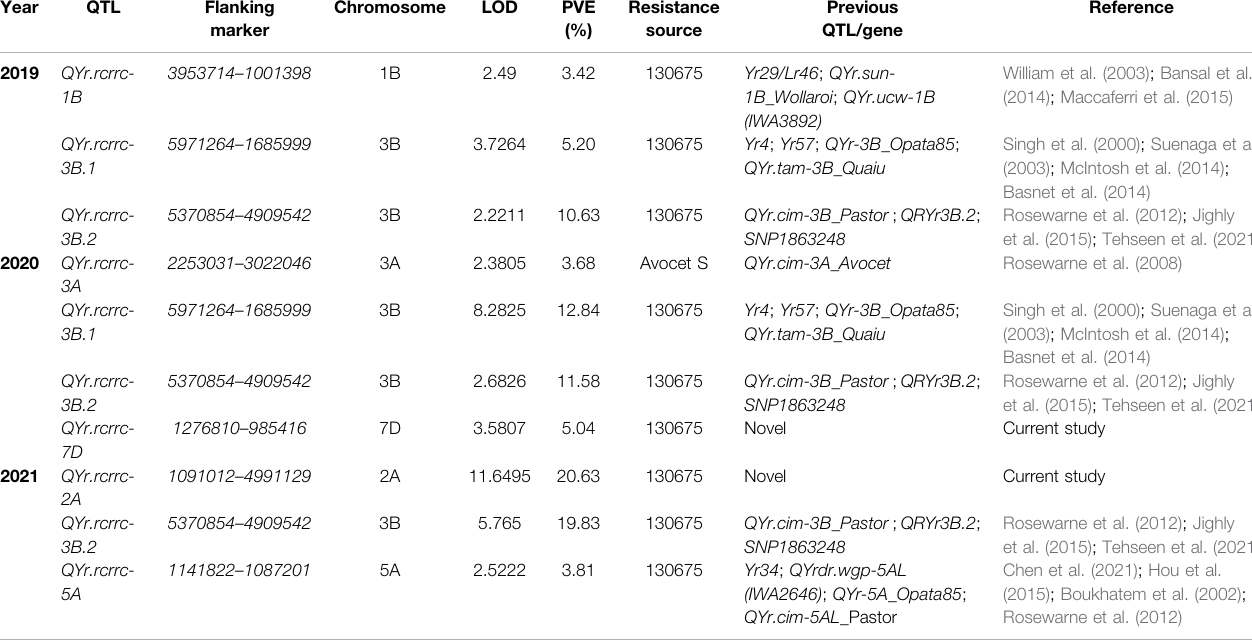
TABLE 3 | Quantitative trait loci (QTLs) associated with adult plant stripe rust resistance in DH population in different environments.